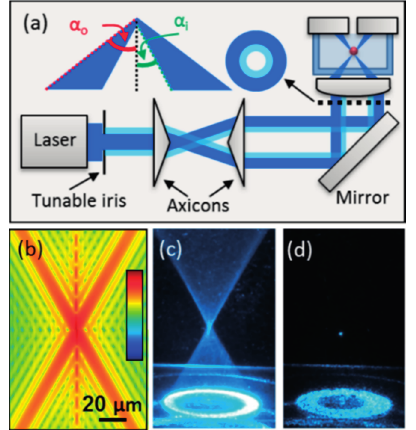
Figure 5. ( a ) Schematic of the optical trapping apparatus used to trap both transparent and absorbing airborne particles of arbitrary morphology using a single shaped hollow laser beam. The aspheric lens forms a hollow conical focus within a glass chamber where airborne particles are trapped; ( b ) Calculated intensity profile near the focal spot plotted on a log-scale; ( c ) Image of the conical focal region produced inside the chamber obtained by introducing Johnson Smut Grass Spores and recording a long exposure time image; ( d ) Image of a spore trapped in air near the focal point [44] (Fair Use according to